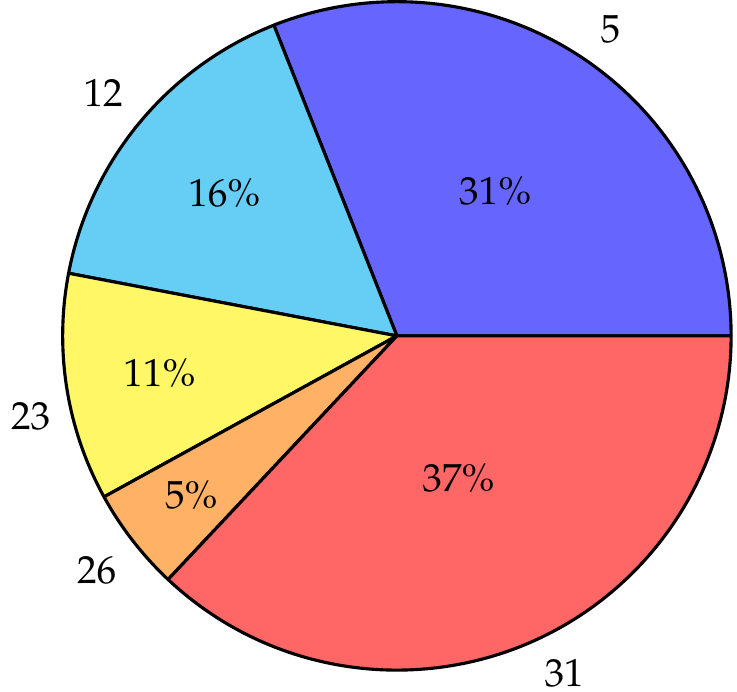
Figure 1. Example: Assets and their corresponding weights as pie chart. Algorithm 3: Set-Based Particle Swarm Optimization for Portfolio